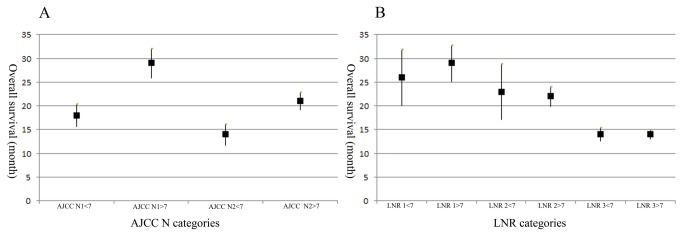
Comparison of prognostic discrimination power between the traditional AJCC N categories and LNR categories.Y axis, the mean and 95% confidence interval of overall survival (month). X axis, A. different AJCC N stage with 7 above lymph nodes resected or not; B. different LNR stage with 7 above lymph nodes resected or not.